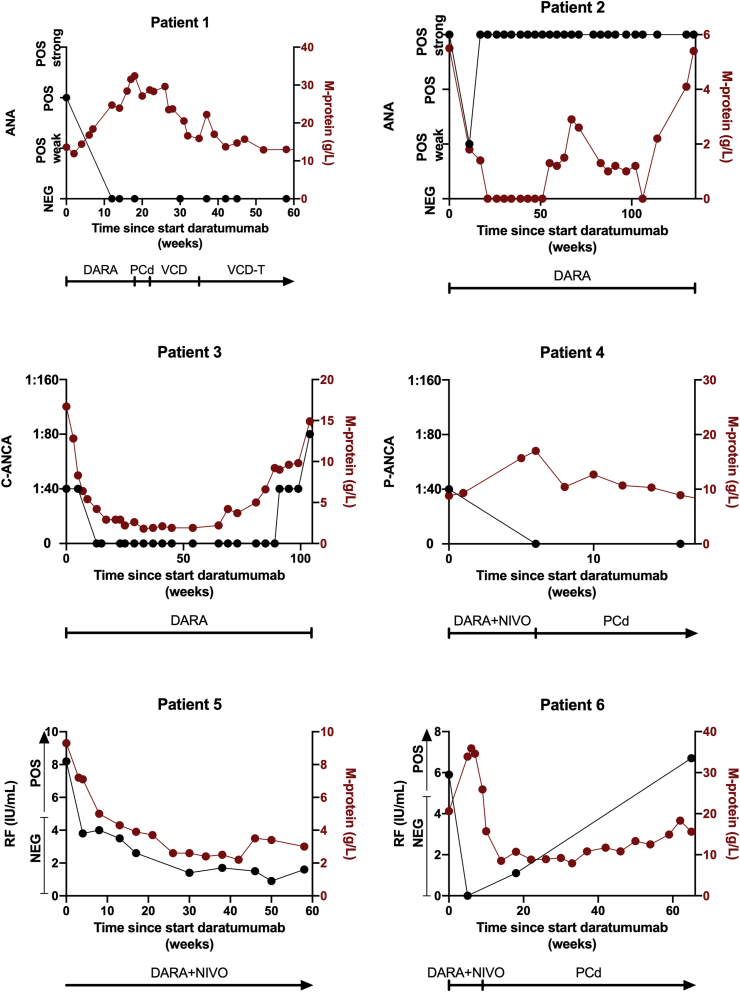
Daratumumab reduces autoantibody levels in multiple myeloma patients. Six out of 41 evaluated patients had positive autoantibody titers prior to initiation of treatment with daratumumab monotherapy (patients 1, 2, and 3), or daratumumab plus nivolumab (patients 4, 5, and 6). Daratumumab was administered as an intravenous infusion at a dose of 16 mg/kg (8-times once weekly, 8-times biweekly, and then every 4 weeks until disease progression). Nivolumab was administered as an intravenous infusion at a dose of 240 mg biweekly for the first 24 weeks, and 480 mg every 4 weeks hereafter until disease progression. The black lines show the effect of daratumumab on antinuclear antibodies (ANA; patients 1 and 2), anti-neutrophil cytoplasmic antibodies (ANCA; patients 3 [C-ANCA] and 4 [P-ANCA]), and rheumatoid factor (RF; patients 5 and 6). Anti-tumor response, as determined by evaluation of M-protein levels, is also demonstrated for each patient in the graphs (red lines). If patients developed disease progression during daratumumab treatment and received a subsequent line of anti-MM therapy, autoantibody titers and anti-tumor responses to subsequent therapies are also shown. Abbreviations: DARA, daratumumab; PCd, pomalidomide-cyclophosphamide-dexamethasone; VCD, bortezomib-cyclophosphamide-dexamethasone; VCD-T, bortezomib-cyclophosphamide-dexamethasone-thalidomide; NIVO, nivolumab.